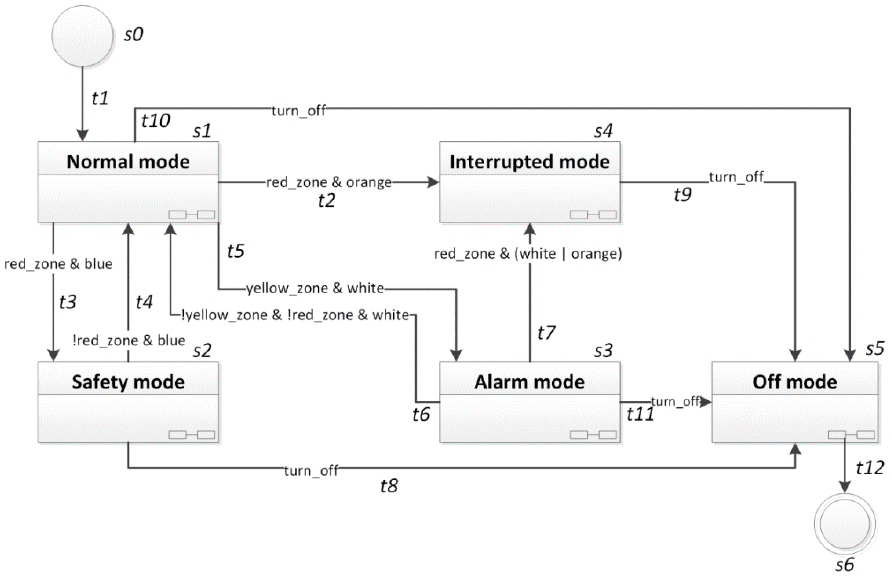
Figure 5. A high-level UML state machine diagram for the case study.